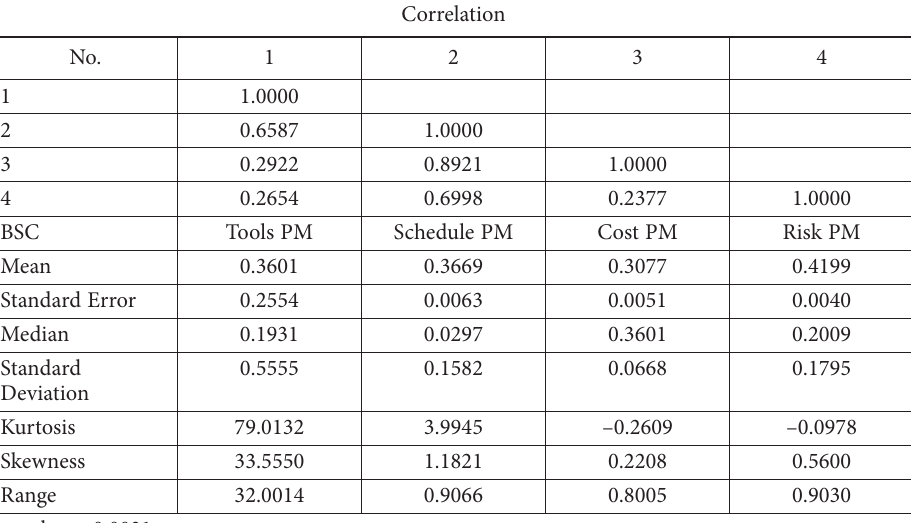
Table 1. Descriptive statistics for hypothesis 1 data (n = 1,143) (source: own